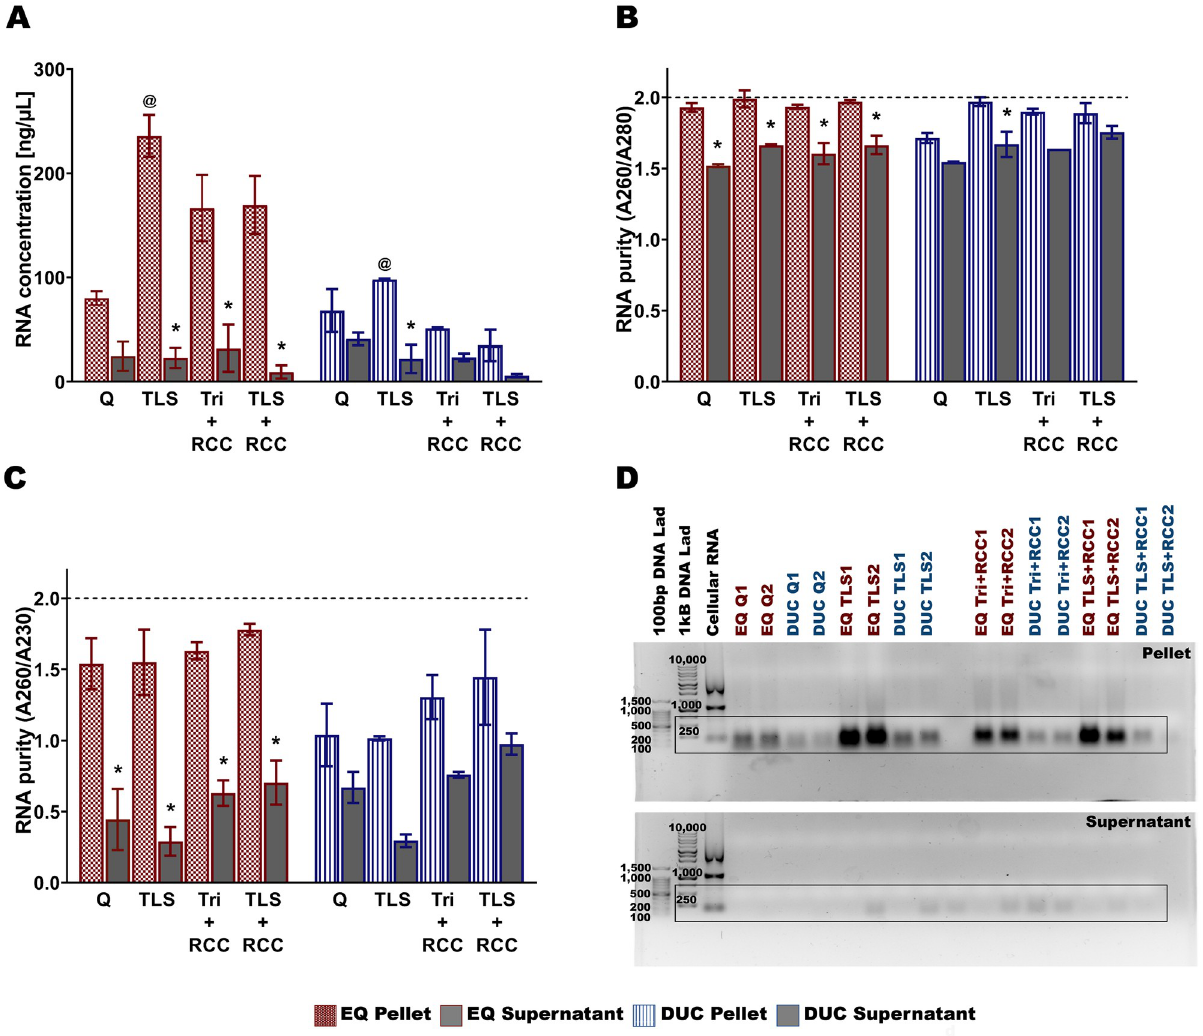
Fig 11. RNA yield [ng/ μ L], purity and quality of human milk-derived exosome pellets and supernatants isolated via ExoQuick (EQ) precipitation and differential ultracentrifugation methods (DUC). RNA was extracted using four protocols, 1) QIAzol + miRNeasy MiniKit (Q), 2) TRIzol LS (TLS), 3) TRIzol + RNA Clean and Concentrator Kit (Tri+RCC), and 4) TRIzol LS + RNA Clean and Concentrator Kit (TLS+RCC). RNA concentration [ng/ μ L] (A), RNA purity—absorbance at 260nm/280nm (B), and absorbance at 260nm/230nm (C), and 1% TAE agarose gel electrophoresis (D) of the RNA samples. Data are mean ± SEM with n = 3 independent trials/group. @ Main effect of RNA extraction protocol (p � 0.05). � Significant difference in RNA concentration and purity between the pellets and supernatants (p � 0.05).